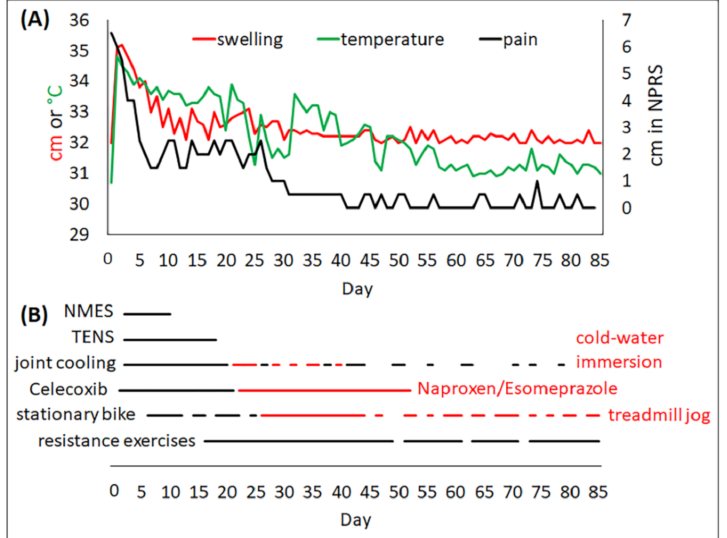
Figure 2. Changes in dependent measurements ( A ), and time course of postoperative interventions ( B ). Note that the line colors correspond to the dependent variables on the y-axes ( A ) and therapeutic interventions ( B ) with the same font colors. The figure ( A ) has left (knee joint circumference in cm and knee joint skin temperature in ◦ C) and right (pain perception during daily activities in cm) axes. The lines in figure ( B ) indicate the days of application in the specific interventions. For example, Celecoxib was administered for the first 21 days, followed by Naproxen/Esomeprazole from day 22 to 52 of rehabilitation. NPRS: numeric pain rating scale; NMES: neuromuscular electrical stimulation; TENS: transcutaneous electrical nerve